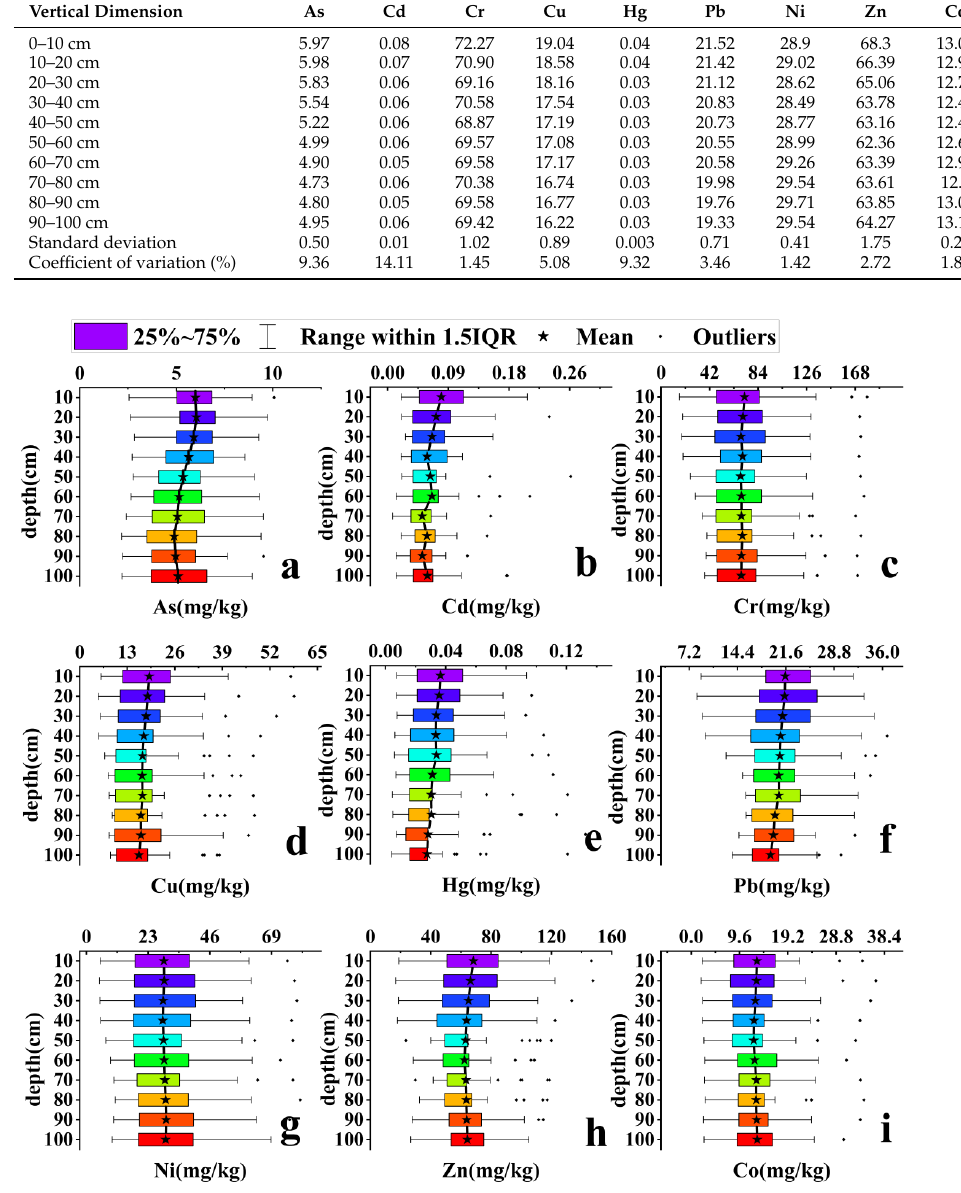
Figure 4. ( a – i ) Heavy metals (As, Cd, Cr, Cu, Hg, Pb, Ni, Ni, Zn, Co) at each layer from 0 – 100 cm in thewetland sediment.